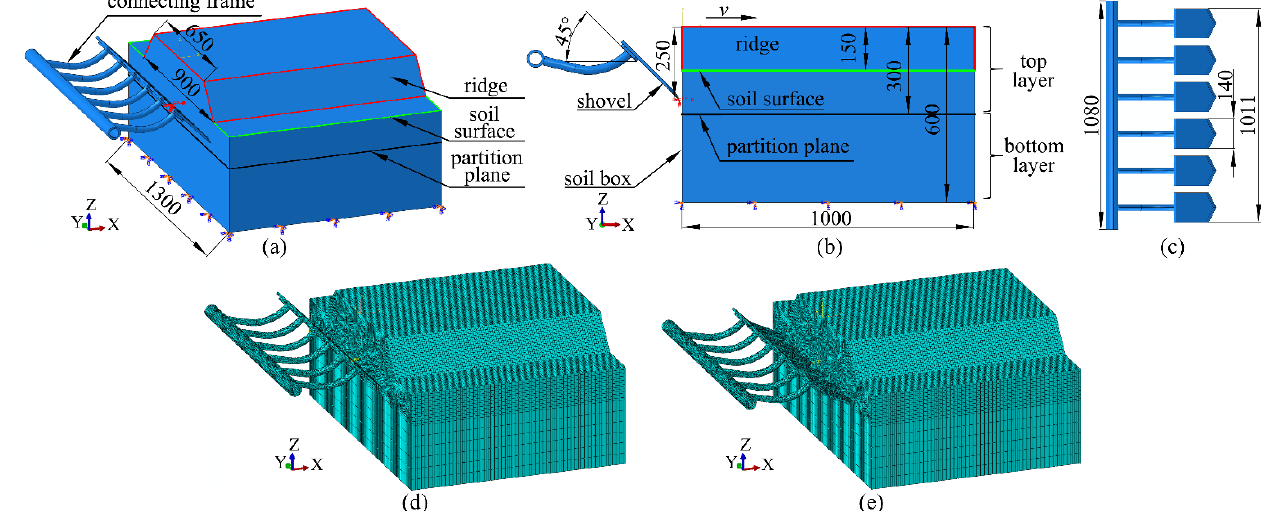
Figure 4. FE models for the interactions between soil and grouped shovels (dimensions in mm). ( a ) Axonometric drawing, ( b ) right side view, ( c ) grouped shovels, ( d ) finite element mesh of soil box being cut with grouped DZ and ( e ) finite element mesh of soil box being cut with grouped YS. v is the cutting speed at 0.56 m/s.